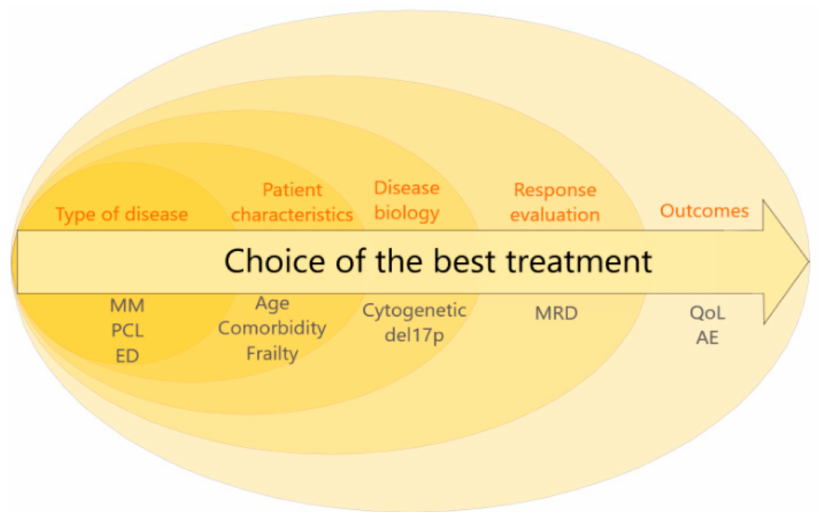
Figure 1. Multiparametric and dynamic model to consider the best treatment choice for one patient. MM: multiple myeloma, PCL: plasma cell leukemia, ED: extramedullary disease, MRD: minimal residual disease, QoL: quality of life, AE: adverse